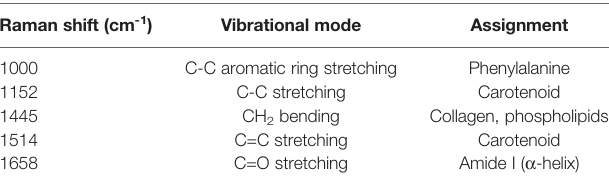
total data as test samples, the classi fi cation accuracy of 1D-CNN, RF, SVM and KNN are 88.6%, 92.8%, 91.5% and 88.9%, respectively. It is clear that the RF and the SVM classi fi cation